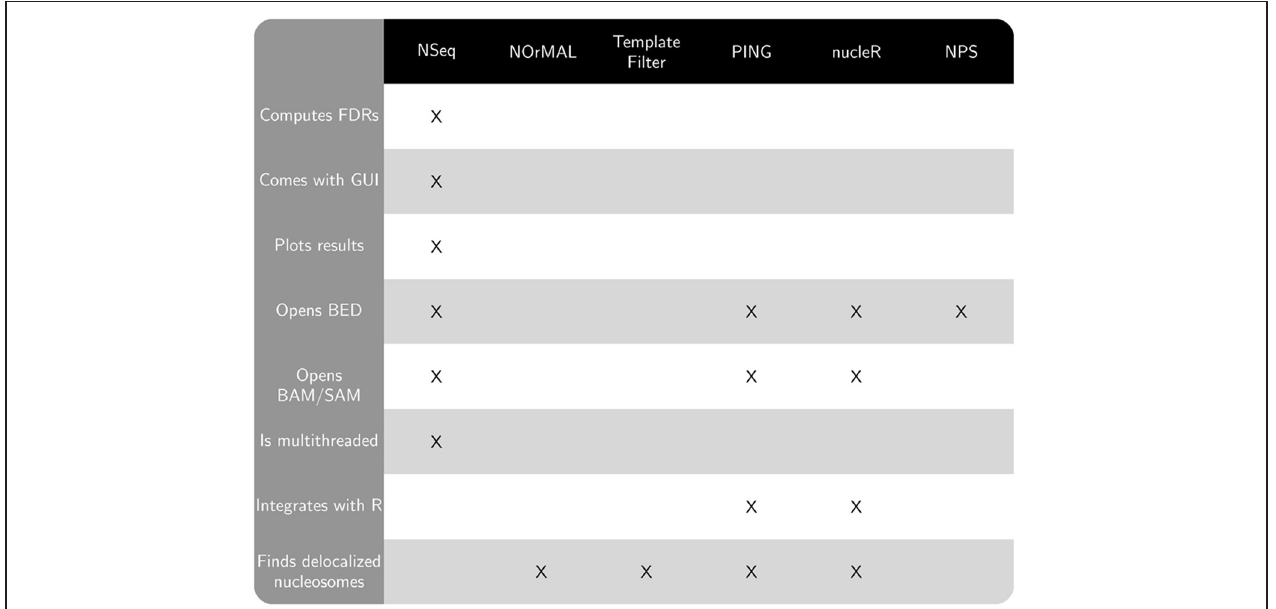
FIGURE 1 | Chart comparing features of NSeq and other publicly available nucleosome sequencing software.